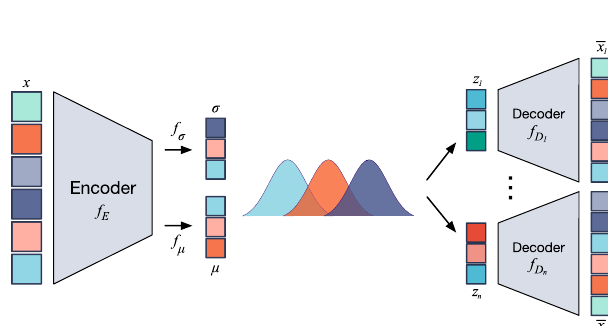
Fig. 4 High-level representation of stacked Bayesian autoencoder. The encoder projects input data to multiple low-dimensional latent spaces (outputs of z 1 to z n layers). The decoders infer original data from these latent data. Minimizing the difference between inferred data and original one leads to a high quality representation of the original data at bottleneck layer (outputs of μ